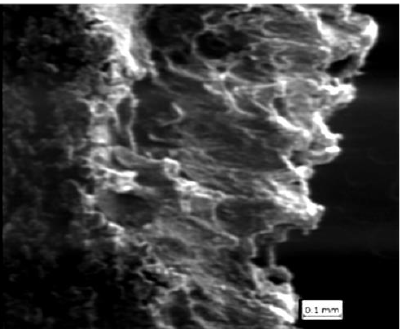
Figure 5. Scanning electron micrographs of the break edge for pure nylon-11.